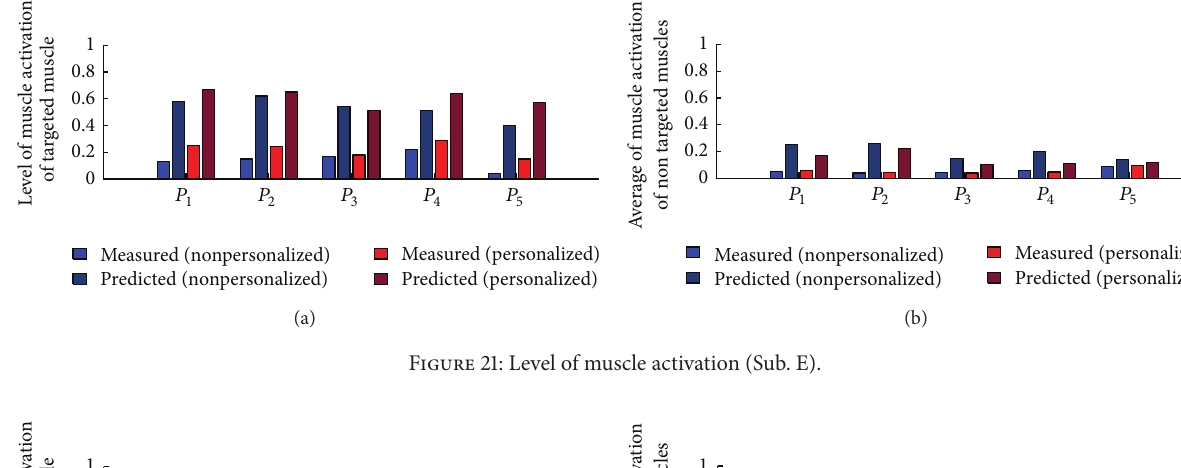
Figure 21: Level of muscle activation (Sub. E).